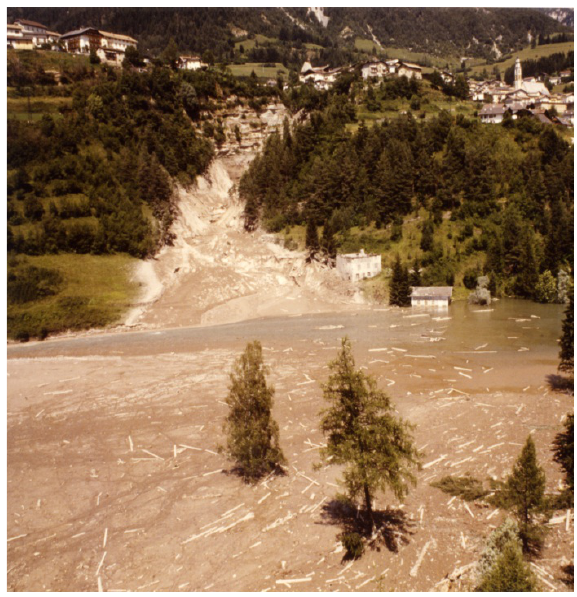
Fig. 15 ‐ Stava creek at the confluence with the Fig. 16 ‐ Just upstream from Stava village, the Fig. 15. Stava creek at the confluence with the Avisio River. In its final confined stretch, the mudflow triggered significant erosion of both sides of the valley and the valley bottom. Along the path, all the trees were removed. On the margins, mud marks reached the tops of trees up to 25m height above the valley floor. In the river bed of the Avisio River, a basin was created that extended about 10ha in total (deposit forming the dam plus the lake behind it) (photo CNR-IRPI Torino, 20 July 1985).